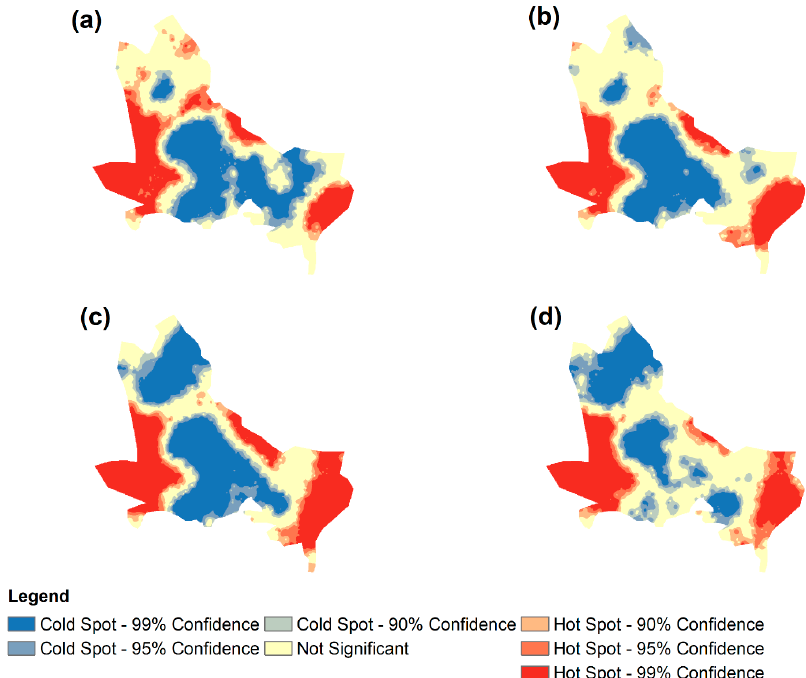
Figure 6. Change in hot and cold spots’ spatial patterns for NDBI during ( a ) 1990, ( b ) 2000, ( c ) 2010, and ( d ) 2020.